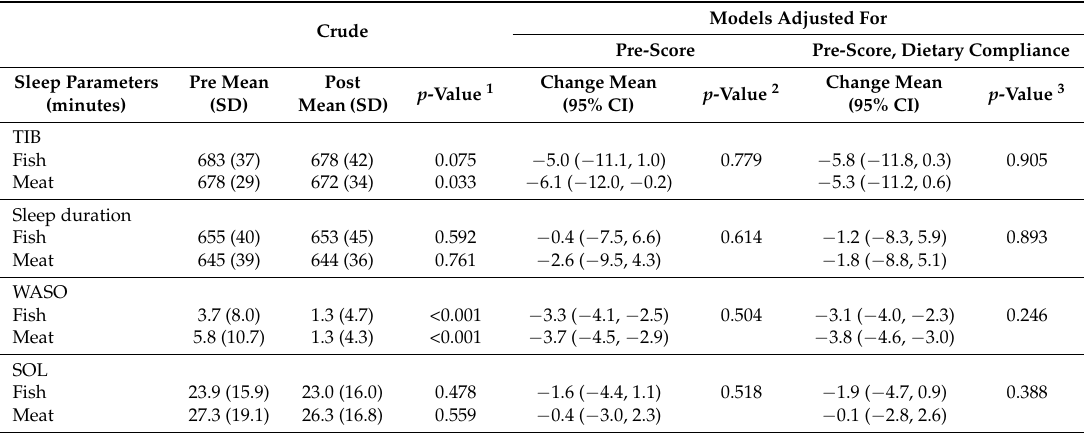
1 Paired-samples t -test for comparison of individual pre- and post-intervention values within each intervention group. 2 Linear mixed effect model adjusted for pre-intervention score. 3 Linear mixed effect model adjusted for pre-intervention score and dietary compliance (amount of fish/meat consumed). Abbreviations: SOL, sleep onset latency, TIB, time in bed; WASO, wake after sleep